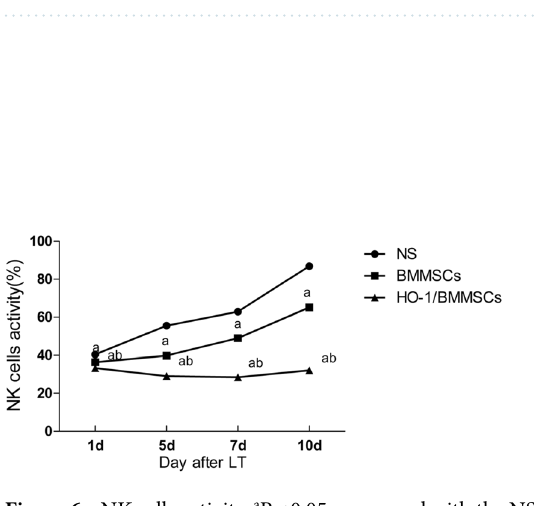
Figure 5. Serum levels of various cytokines. a P < 0.05, compared with the NS group. b P < 0.05, compared with the BMMSC group. c P < 0.05, compared with the HO-1/BMMSC group.